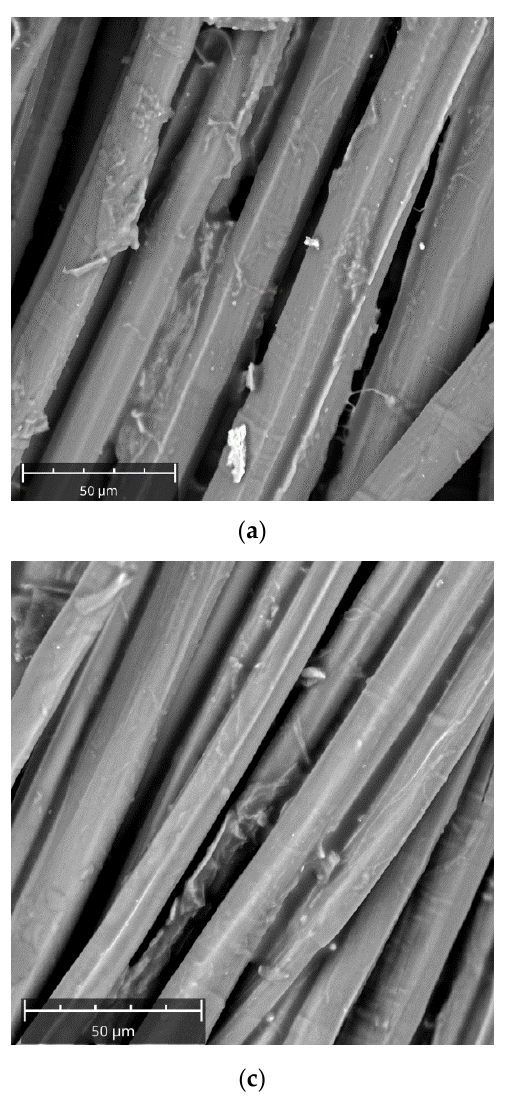
Figure 12. SEM micrographs of flax fibers for each treatment condition: ( a ) R, ( b ) C5, ( c ) C10 and ( d ) C20 fibers. On the other hand, the diameter reduction experienced by 5% and 10% treated fibers can be attributed to the modification induced by the proposed treatment on the chemical structure of the fiber surface, as shown by FTIR spectra of untreated and treated flax fibers (Figure 13). As suggested by literature, all the spectra were baseline corrected to the peak centered at 3337 cm − 1 , attributed to the O-H stretching vibration and hydrogen bond of the hydroxyl groups [16,49,50]. The spectra comparison clearly evidences that, similar to the traditional mercerization, the proposed treatment causes the removal of a certain portion of hemicellulose and lignin from the surface of fibers. Indeed, it is worth noting that the peak centered at 1732 cm − 1 , attributed to the carbonylic group C=O stretching vibration of linkage of carboxylic acid in lignin or ester group in hemicellulose, tends to disappear 1240 cm − 1 , due to the C-O stretching vibration of the acetyl group in lignin, can be